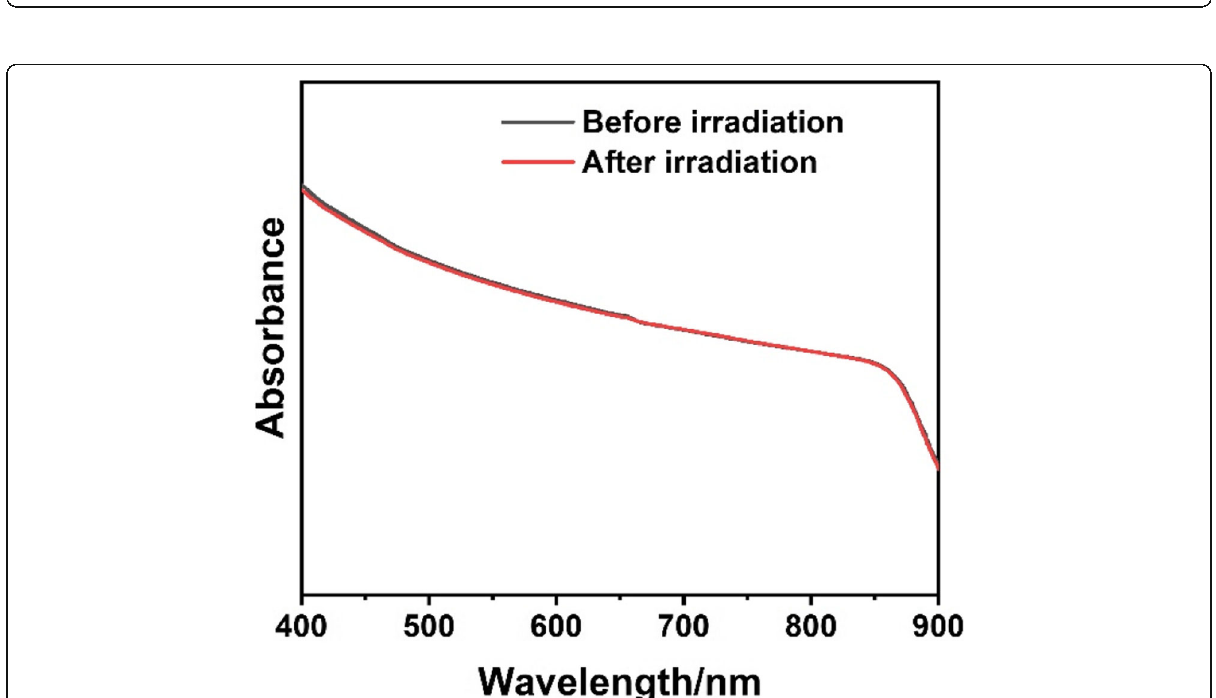
Fig. 8 UV-vis-NIR spectra of NrGO before and after NIR laser irradiation